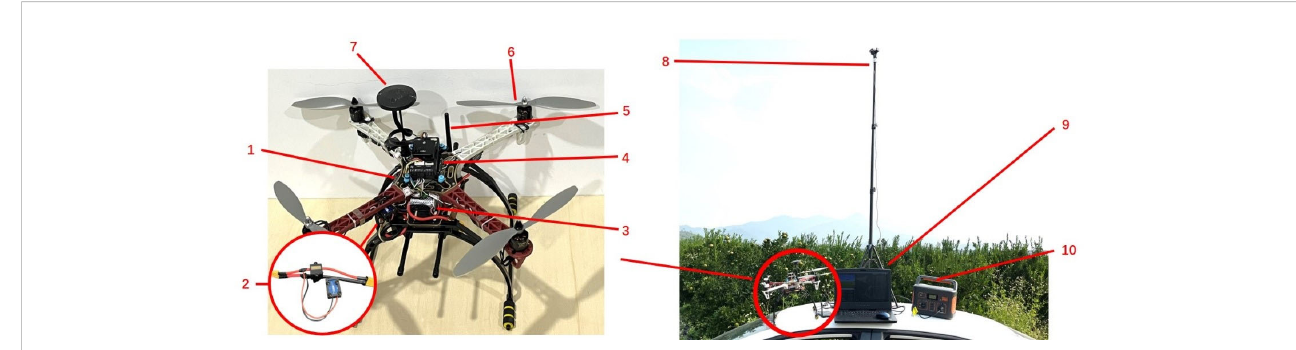
TABLE 2 Simulation results of traditional ant colony algorithm and improved ant colony algorithm.